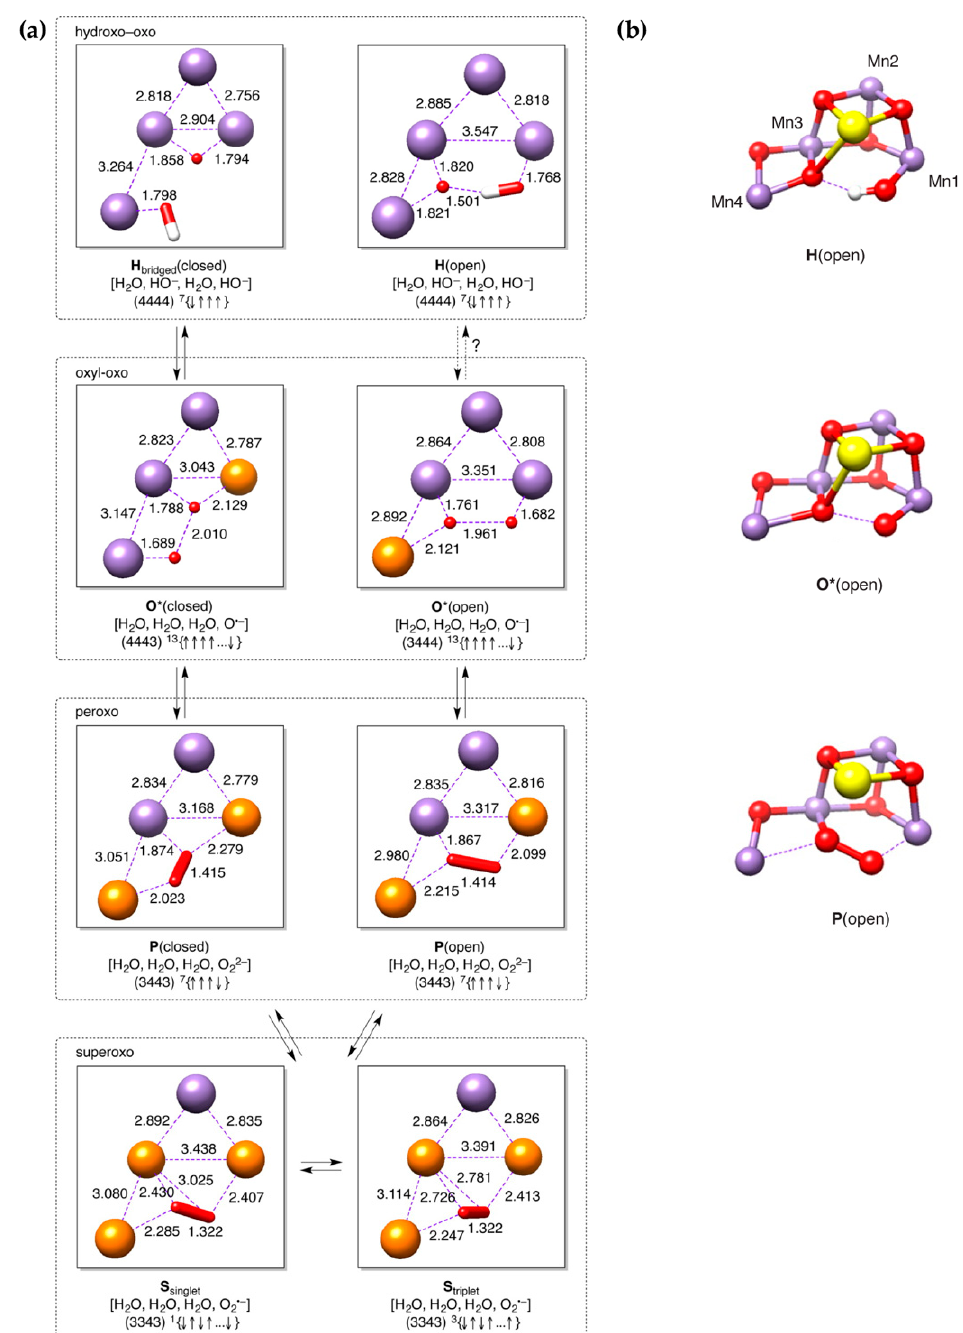
Figure 7. ( a ) Redox isomers attributed to the S 3 state by Isobe et al. [48]. Only the Mn 4 core and the two central O atoms are depicted: Mn(IV) ions are shown in purple and Mn(III) ions in orange. The labels indicate formation of a hydroxo-oxo species ( H ), an oxyl radical ( O* ), peroxo ( P ), or superoxo ( S ); protonation states in brackets refer to W1, W2, W3, and the newly inserted water-derived ligand; the arrows in braces indicate the alignment of local spins in the depicted model. ( b ) Structures of the inorganic cores for selected models. Reprinted with permission from Isobe et al. [48]. Copyright 2016 American Chemical Society.